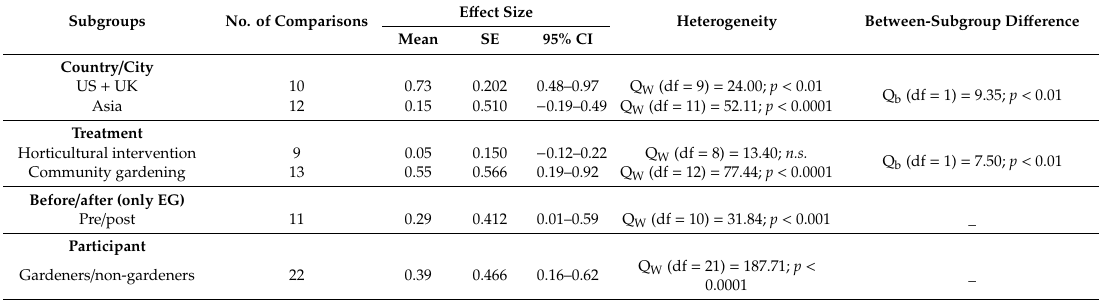
Table 2. Meta-analysis results of each subgroup considered. NOTE: Cochran’s Q is used as a test of heterogeneity among e ff ect sizes. A significant Q w value suggests significant heterogeneity within a group, while a significant Q b suggests significant di ff erences between groups. EG = Experimental Group; n.s. = non-significant; SE = Standard Error; CI = Confidence Interval. ff ect Size Heterogeneity Between-Subgroup Di ff erence No. of Comparisons E